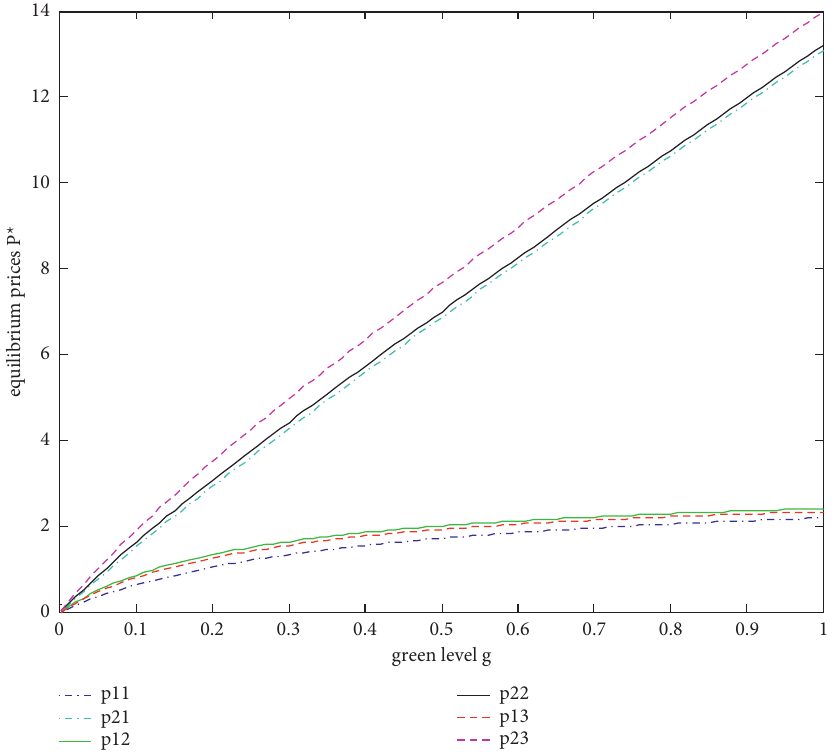
Figure 2: Equilibrium prices with green